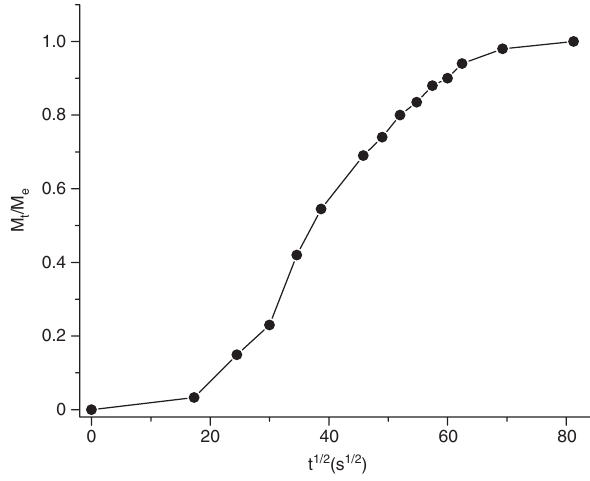
/ M and t 1/2 coor- t e